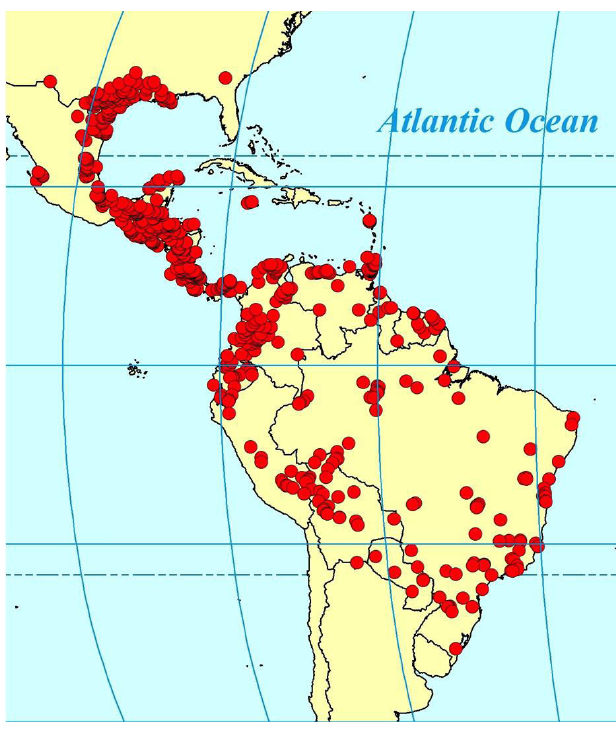
Fig 2 . Geographic distribution of Pachycondyla harpax